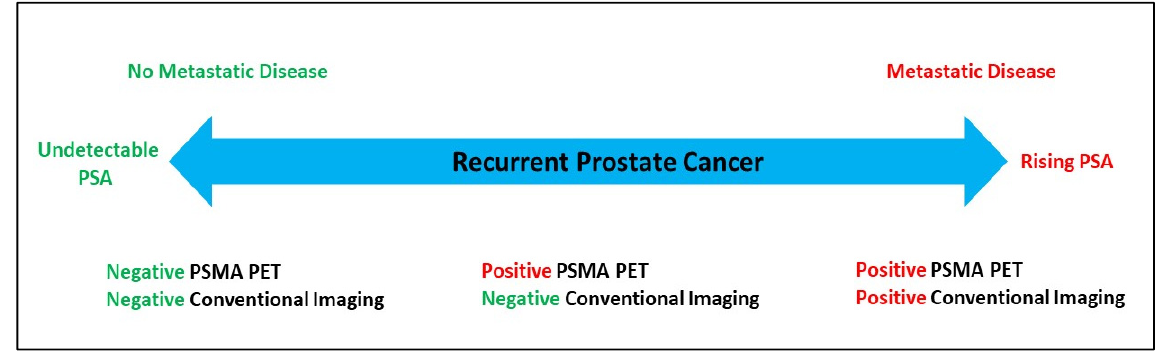
Figure 1. Continuum of metastatic disease in the setting of PSMA